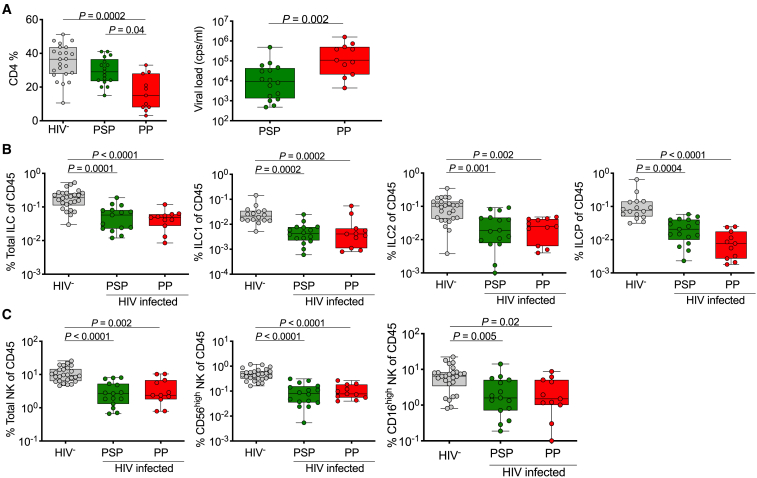
Depletion of Peripheral Helper ILC and Cytotoxic NK Cell Subsets in Treatment-Naive HIV-Infected Pediatric Subjects(A) CD4 percentage of CD45+ lymphocytes (left) and plasma viral load (right) of pediatric HIV-uninfected (HIV−) subjects (n = 25), pediatric slow progressors (PSPs) (n = 15), and pediatric progressors (PPs) (n = 11) (see Table 1).(B) As in (A) but showing total ILC (left), ILC1 (center left), ILC2 (center right), and ILCP (right) subset levels as percentage of CD45+ lymphocytes. Gating as in Figure 1A.(C) As in (B) but showing total NK cells (left) and NK subsets (CD56high, middle; CD16high, right) as percentage of CD45+ lymphocytes.p values by Dunn’s multiple comparisons test.